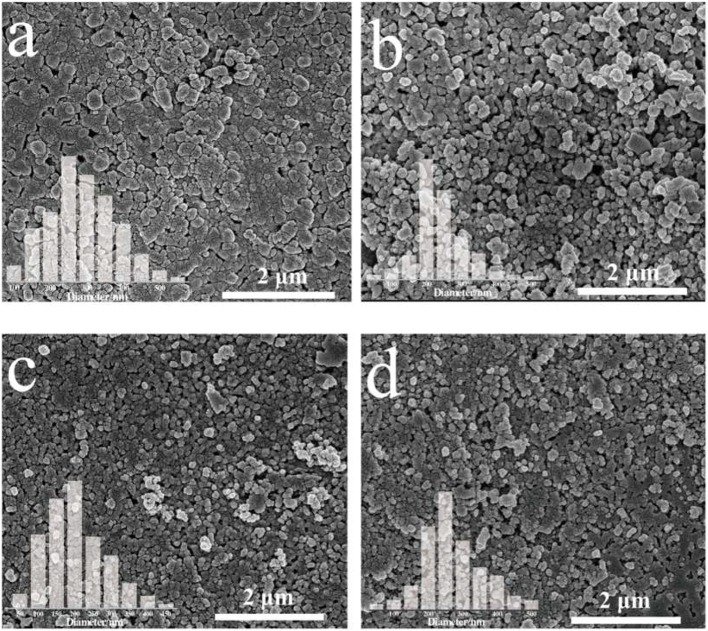
SEM images and particle range of (a) pure BiVO4; (b) BiVO4(Mo-1); (c) BiVO4(Mo-3); (d) BiVO4(Mo-5).